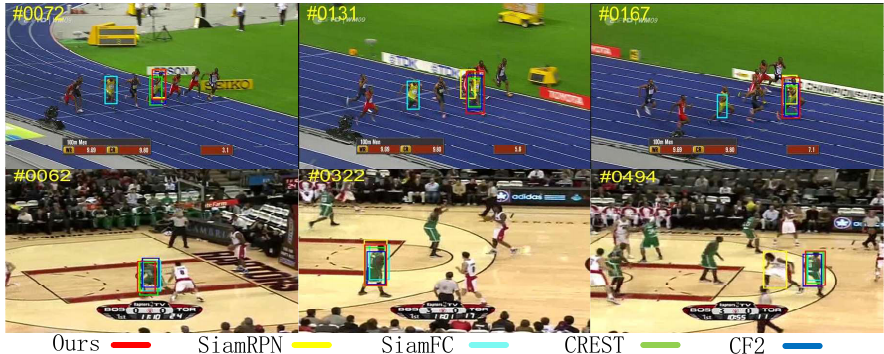
Figure 1. Comparison of our tracker with other trackers for Bolt ( top ), Basketball ( bottom